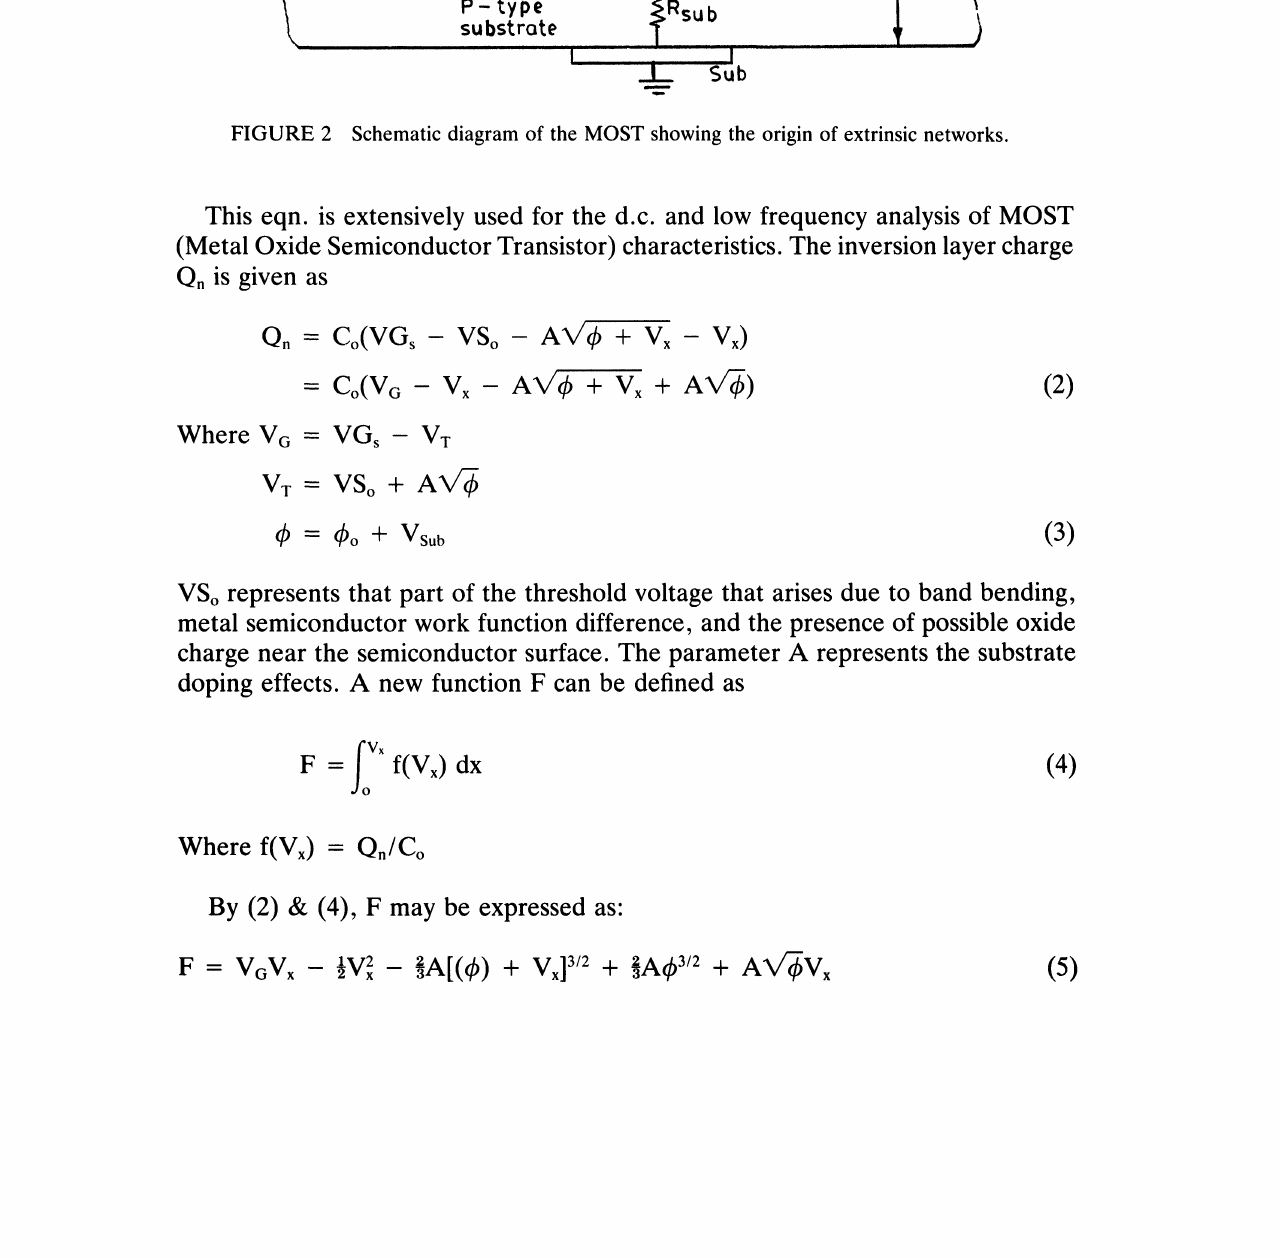
FIGURE 2 Schematic diagram of the MOST showing the origin of extrinsic